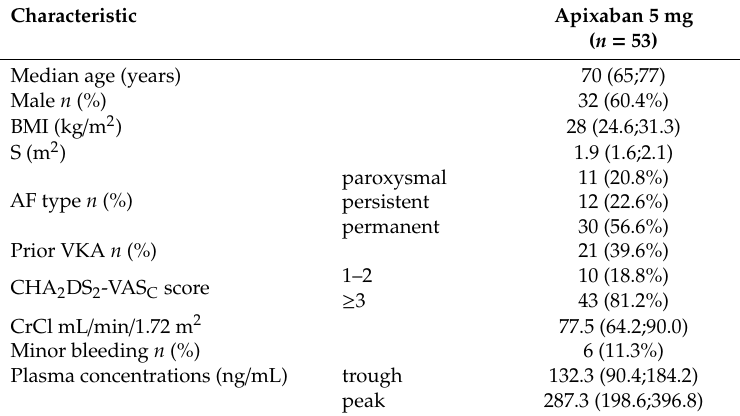
Table 1. Baseline characteristics of the patients included in the